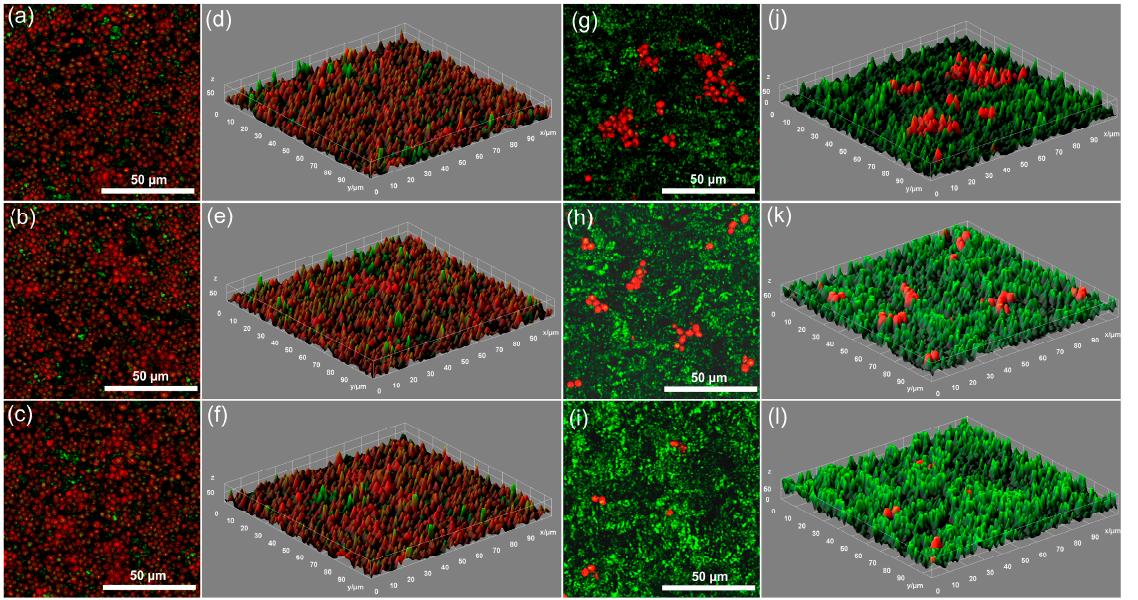
Figure 11. Two-dimensional (2D) confocal laser scanning microscopy (CLSM) images and 3D representation of Candida albicans ATCC 10,231 adhesion on HAp ( a − f ) and 10Ce-HAp ( g − l ) coatings at different time intervals of incubation 24 h ( a,d,g,j ), 48 h ( b,e,h,k ), and 72 h ( c,f,i,l ).